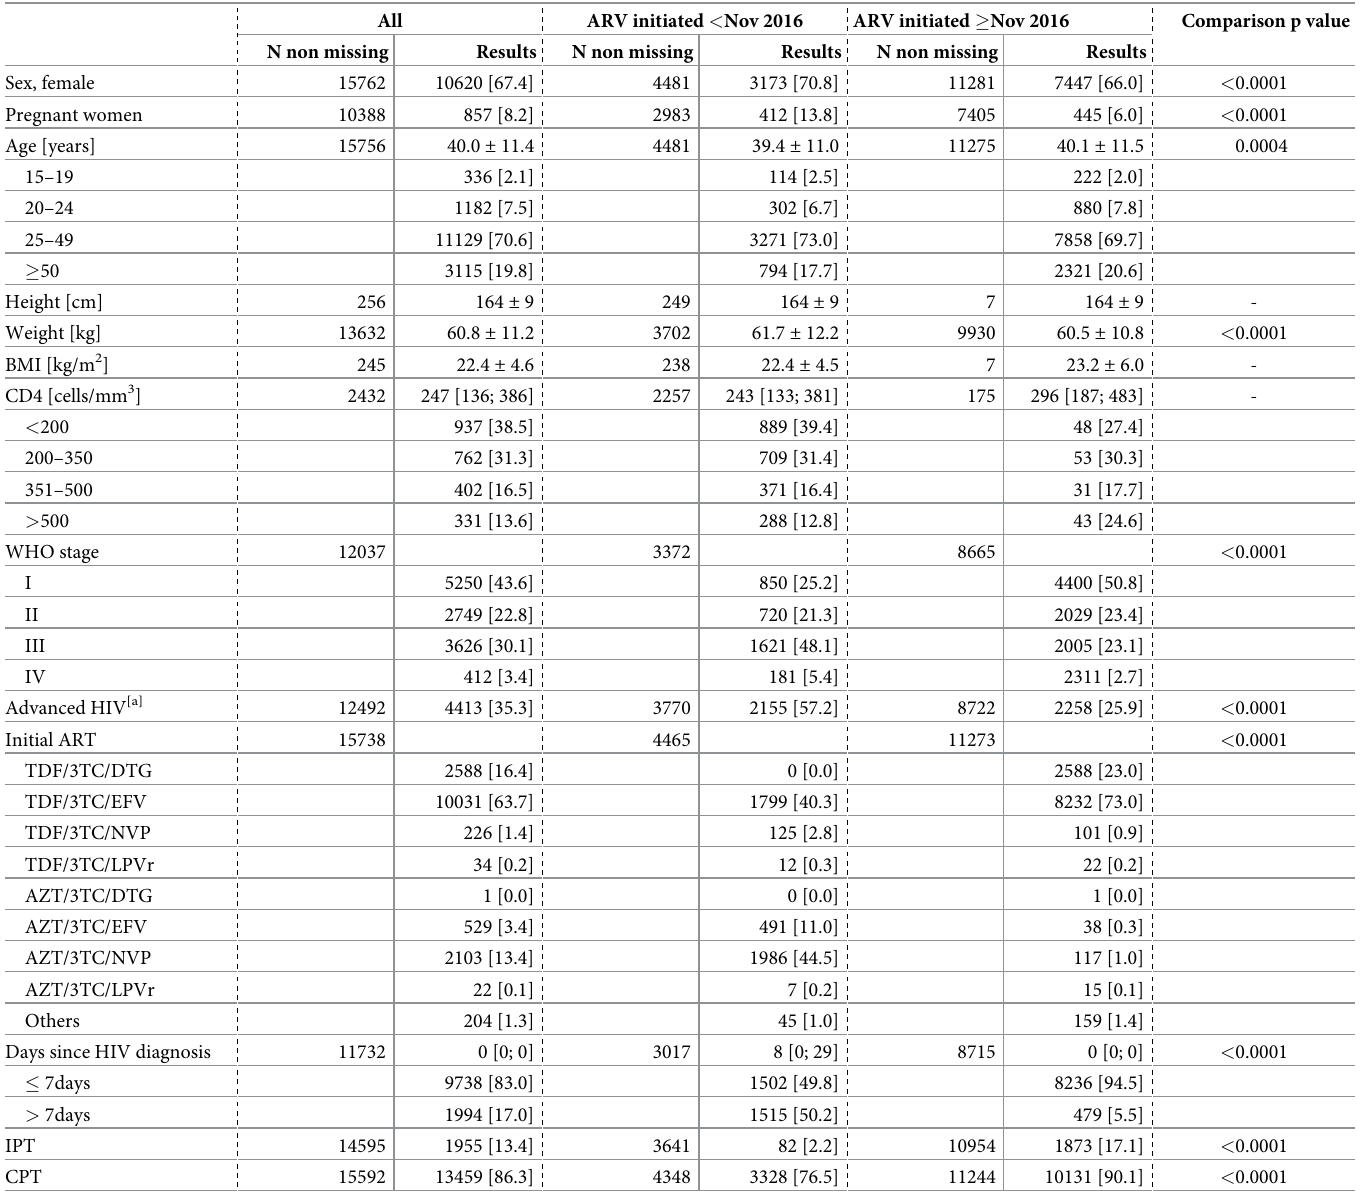
Table 1. Description of PLWH at treatment initiation [N =